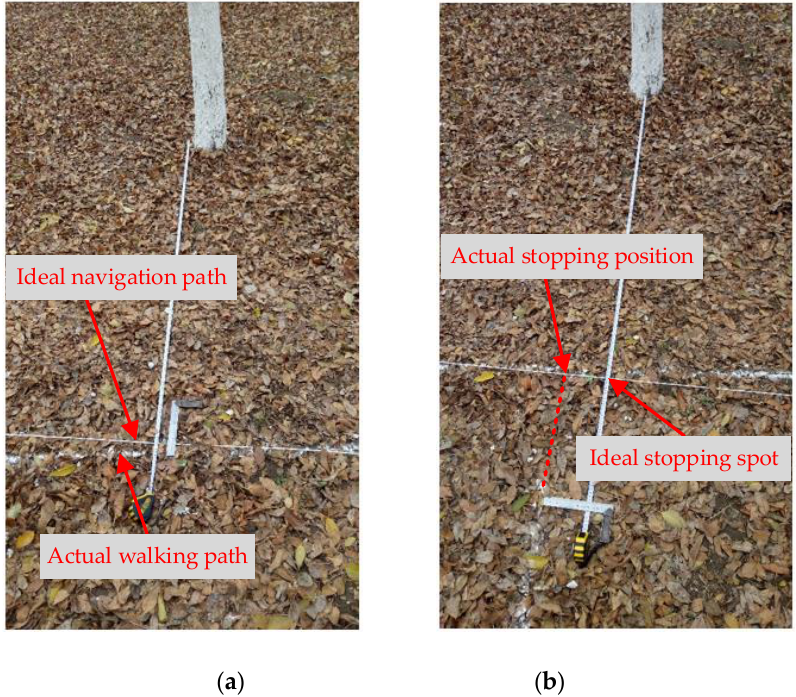
Figure 12. Error measurement. ( a ) Lateral error measurement; ( b ) Front and back error measurement.